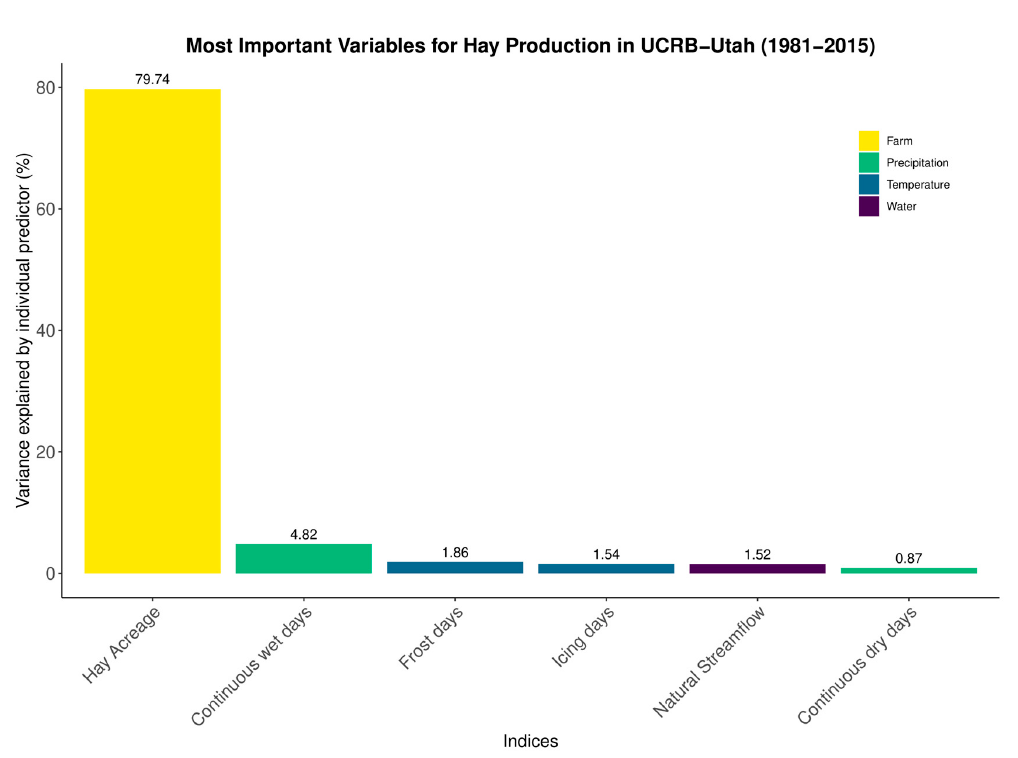
Figure 5. Most important variables for hay production in UCRB-Utah (multilinear regression,